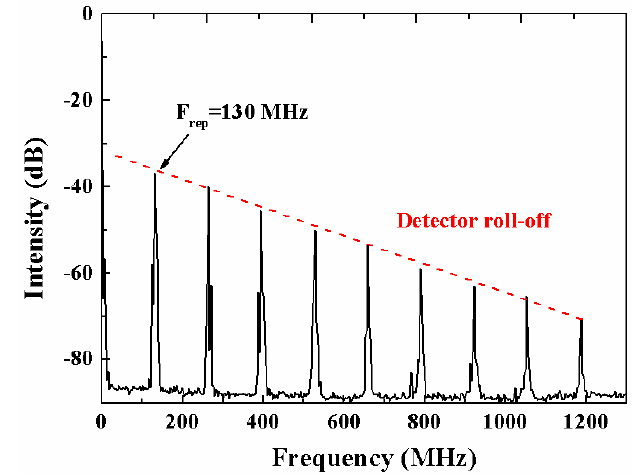
Figure 6. The radio frequency (RF) spectrum of the QML pulses at a resolution bandwidth of 1 kHz.